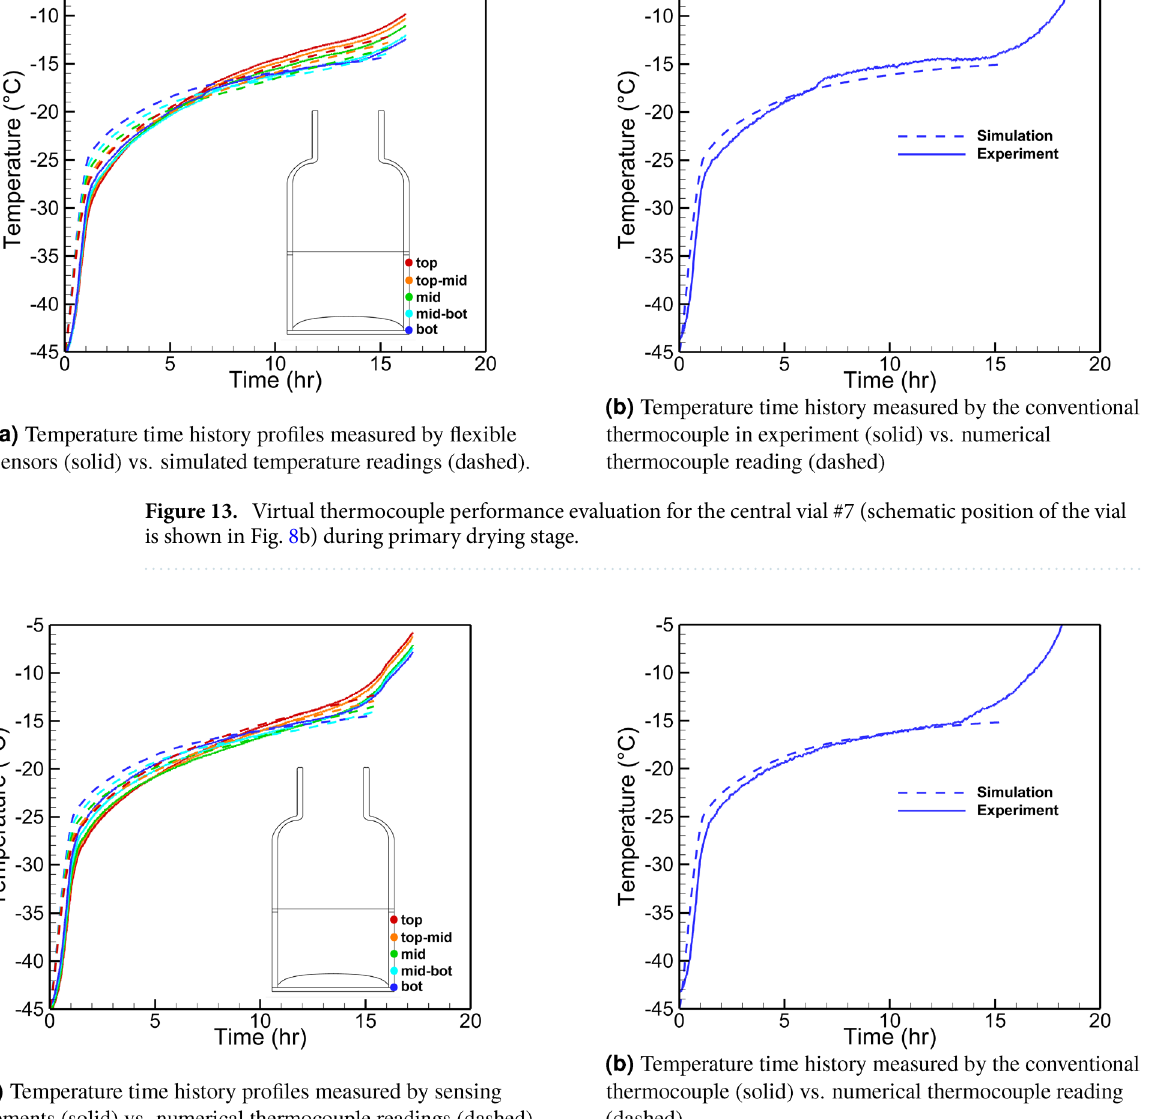
Figure 14. Virtual thermocouple performance evaluation for the central vial #6 (schematic position of the vial is shown in Fig. 8b) during primary drying